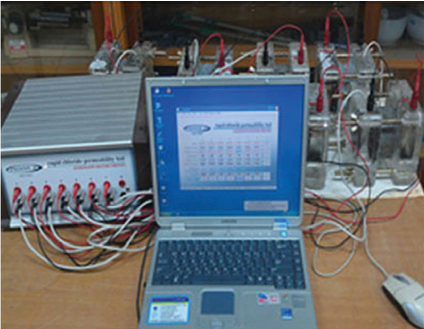
Figure 4: Chloride ion permeability setup. Table 8: Standard of permeability levels by ASTM.